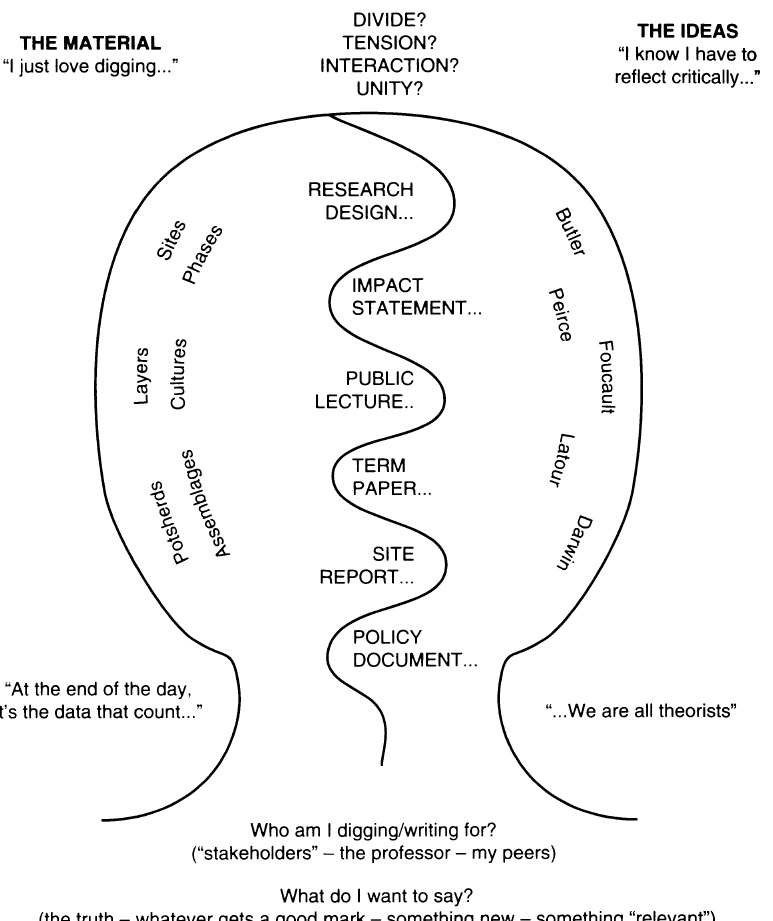
Figure 3: Matthew Johnson’s cartoon illustrating some contemporary – but also deep-rooted – tensions in how we think about archaeology (Johnson 2010: 228; reproduced with